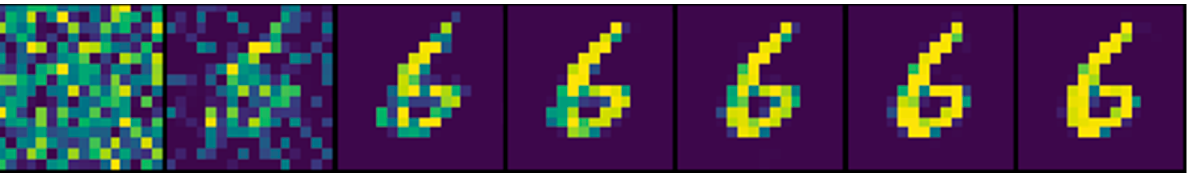
Figure 7. Changes in weight image of a single feature layer during training (samples = 0, 1000, 2000, 3000, 4000, 5000,